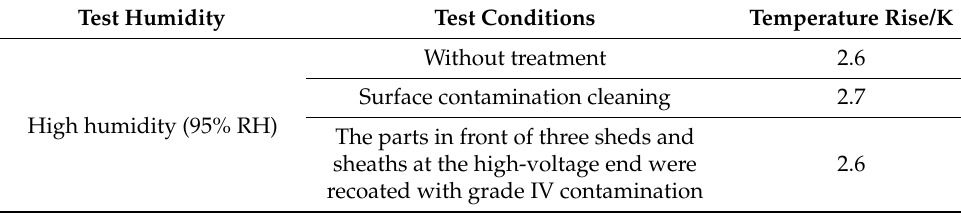
Table 2. Infrared inspection results of sample #1 under different test